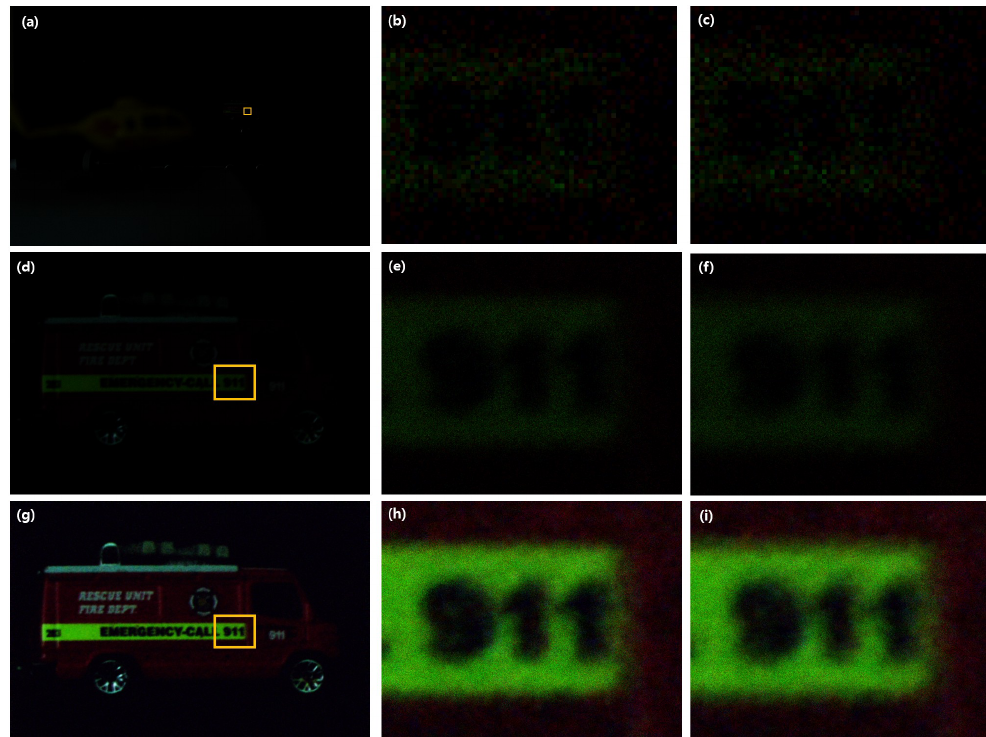
Figure 12. ( a ) Reconstructed three-dimensional image under photon-starved conditions by con- ventional method, ( b , c ) cropped images from results by computational photon counting imaging without digital zooming at 344 mm and 392 mm, ( d ) reconstructed three-dimensional image un- der photon-starved conditions by computational photon counting imaging with digital zooming, ( e , f ) cropped images from results by computational photon counting imaging with digital zooming at 43 mm and 49 mm, where 97,344 photons are used, ( g ) reconstructed three-dimensional image under photon-starved conditions by our method, where 97,344 photons and 10 observations are used, ( h , i ) cropped images from results by our method at 43 mm and 49 mm,